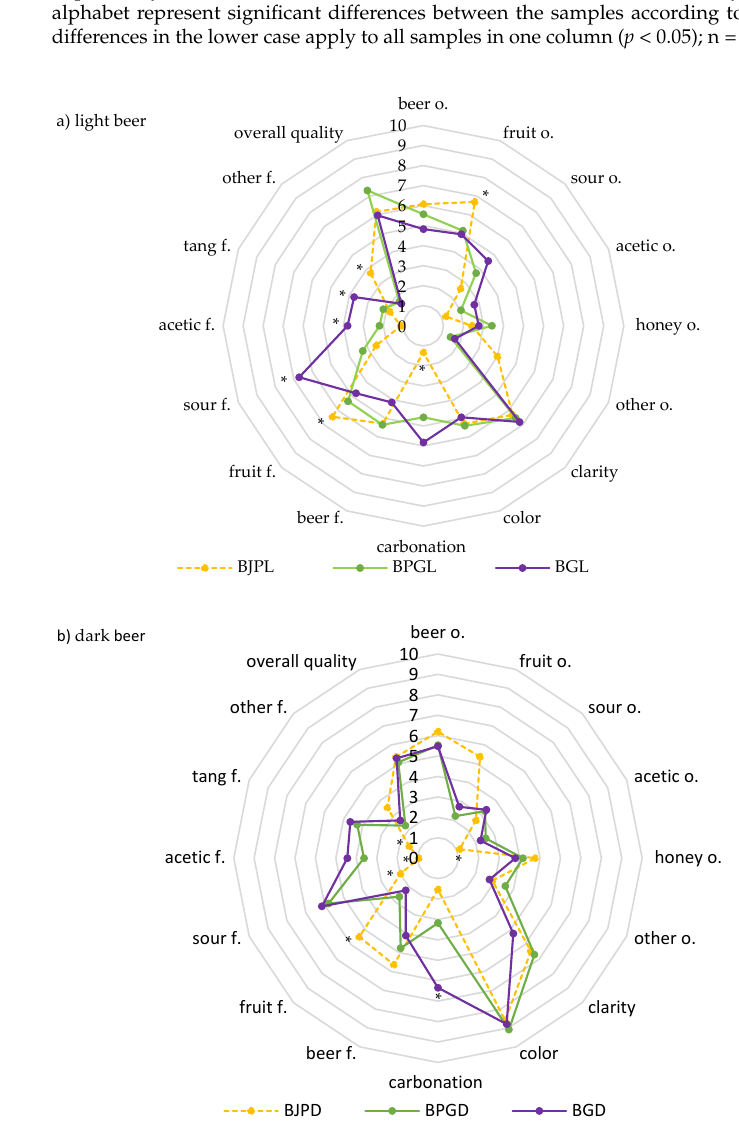
Figure 2. Sensory profiles of the beer beverages after the re-fermentation process (( a )—light beer, ( b )—dark beer); Explanatory notes: o.: odor; int.: intensity; f.: flavor; * indicates sample significantly different from the others according to the ANOVA test ( p < 0.05); n = 16.